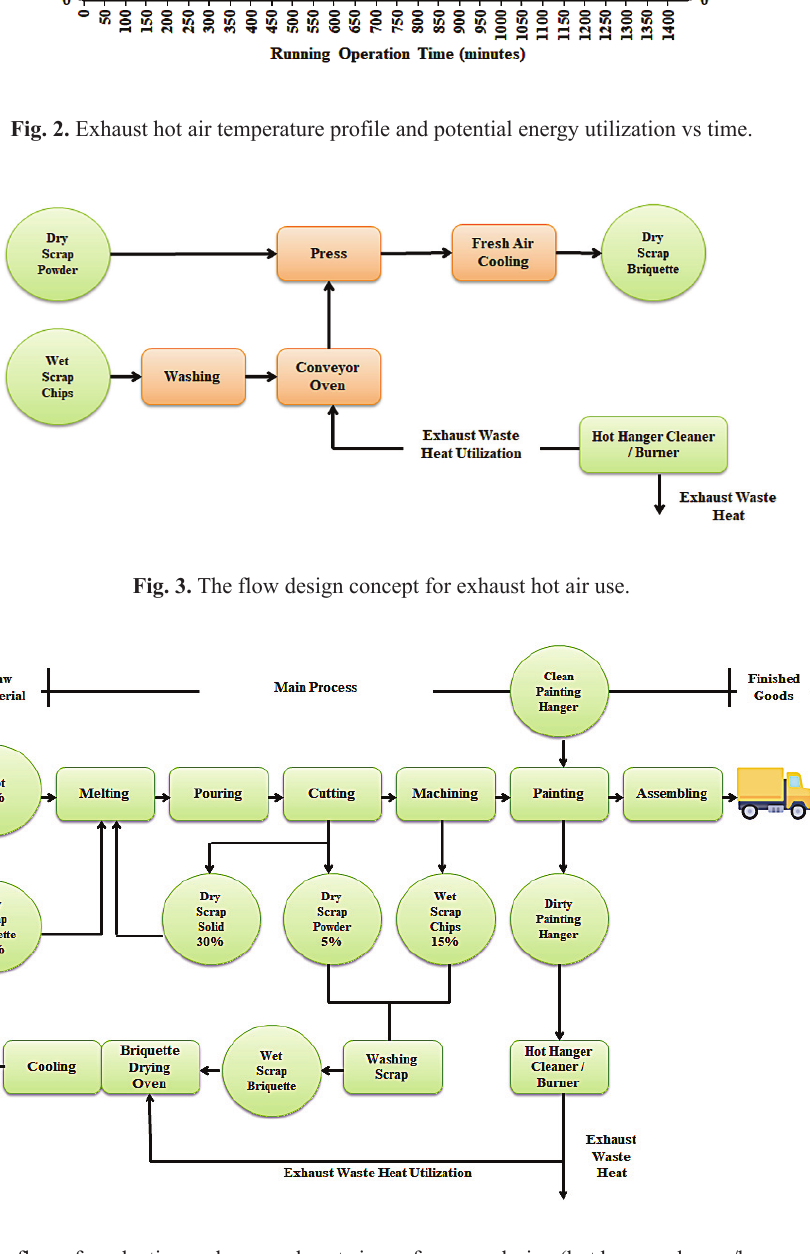
Fig. 4. Modified process flow of production and oven exhaust air use for scrap drying (hot hanger cleaner/burner process as a source of exhaust air